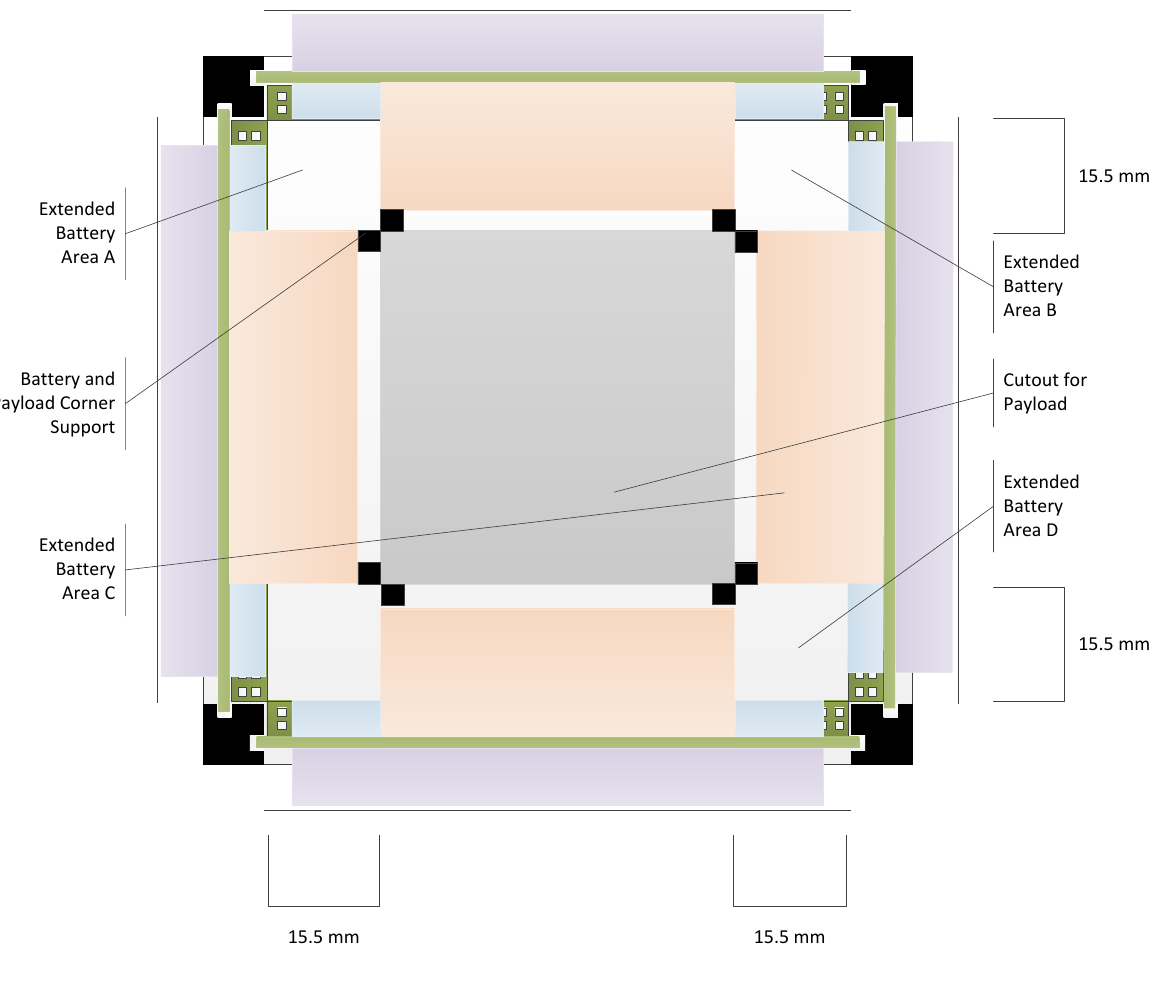
Figure 18. Alternate Payload Support Configuration with Extended Battery